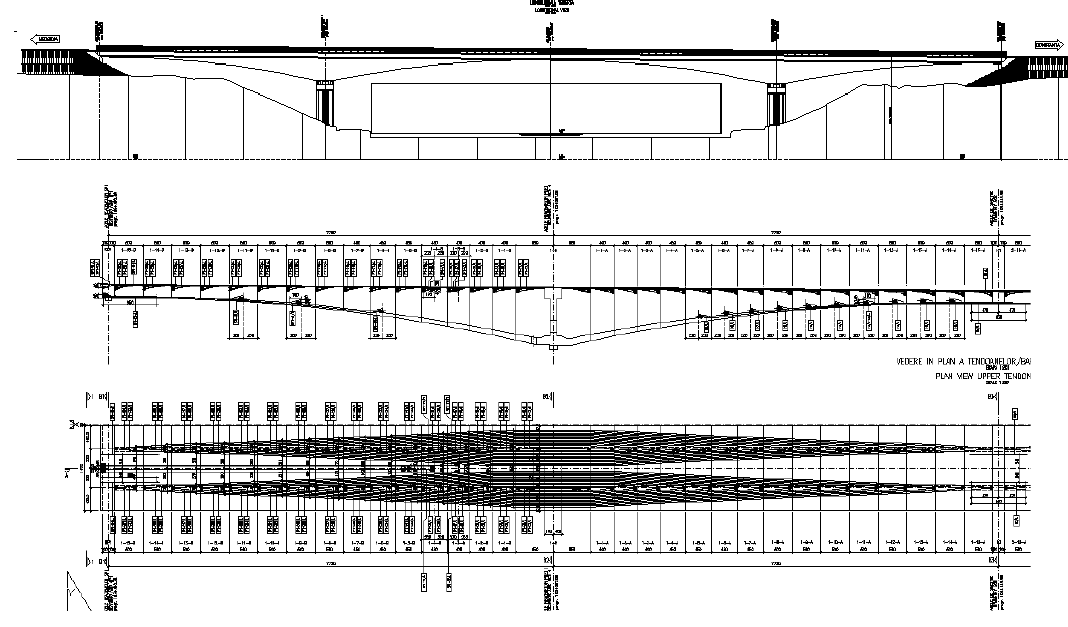
Figure 12. Project description: Upper view and longitudinal